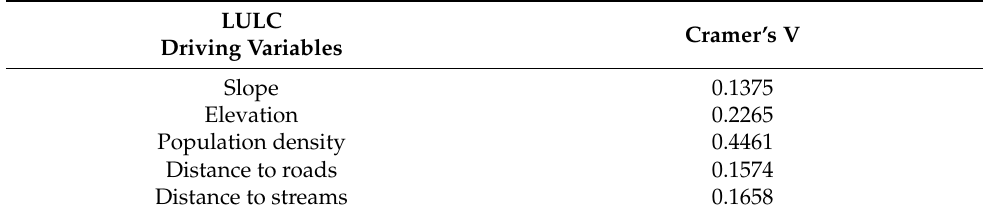
Table 8. Cramer’s V values of LULC driver